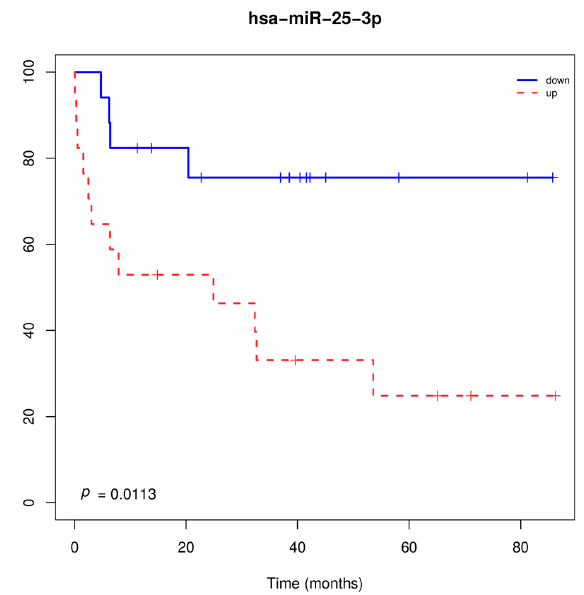
Figure 2. Overall survival of patients with lung carcinoma regardless of the histological subtype, according to miR-25-3p expression levels. Overexpression of miR-25-3p was associated with shorter overall survival.